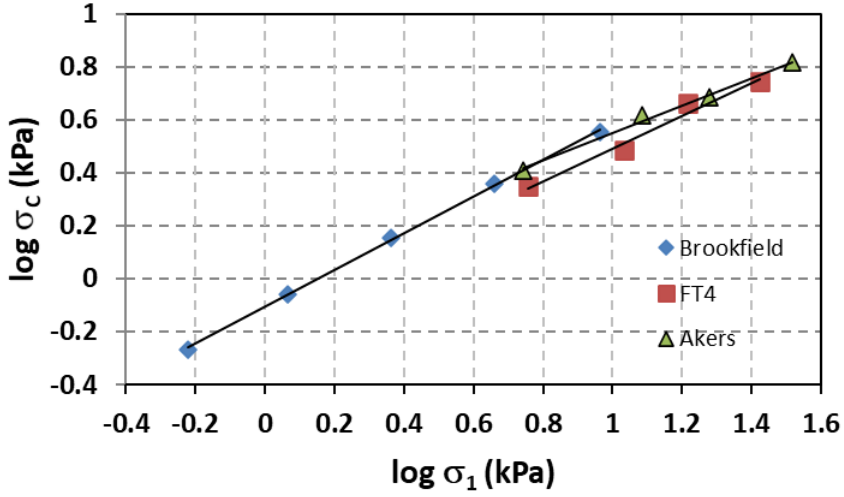
Figure 8. Comparing the flow functions of CRM limestone measured using the Brookfield PFT and Freeman FT4 with data from Akers Freeman FT4 with data from Akers [15].